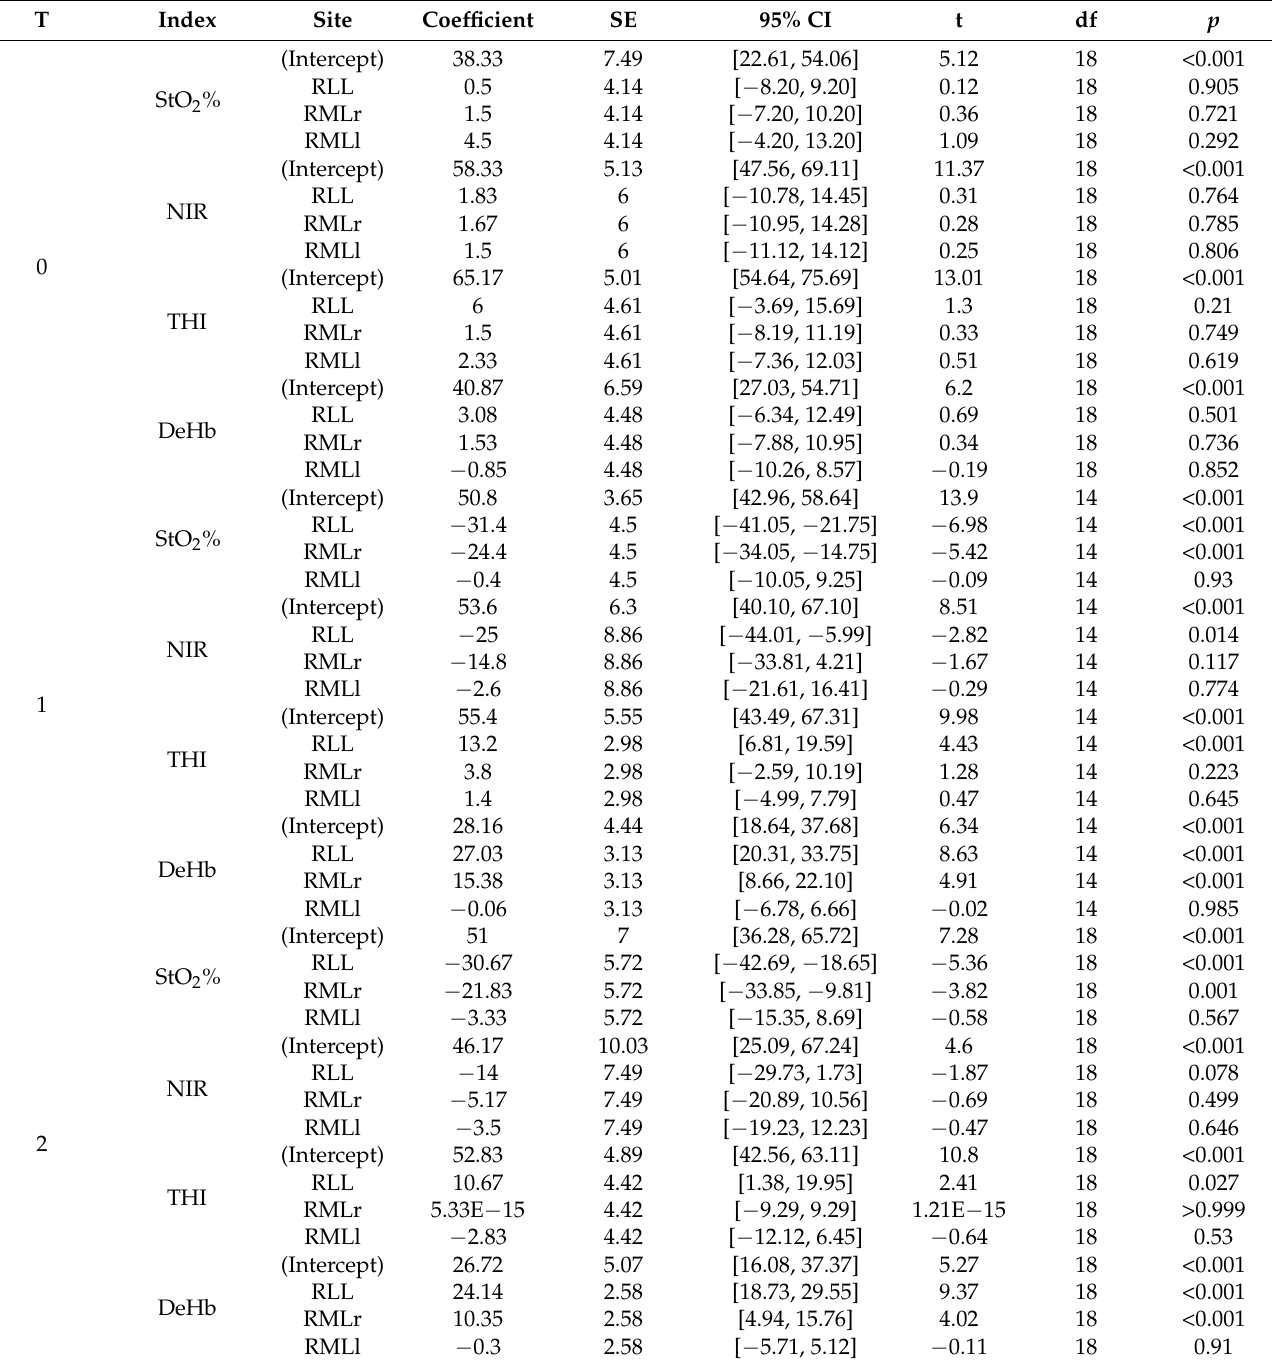
Table 1. Mixed-effects linear regression to estimate the variations of the hyperspectral indexes among different liver lobes. In this table, the reference level is the left lateral